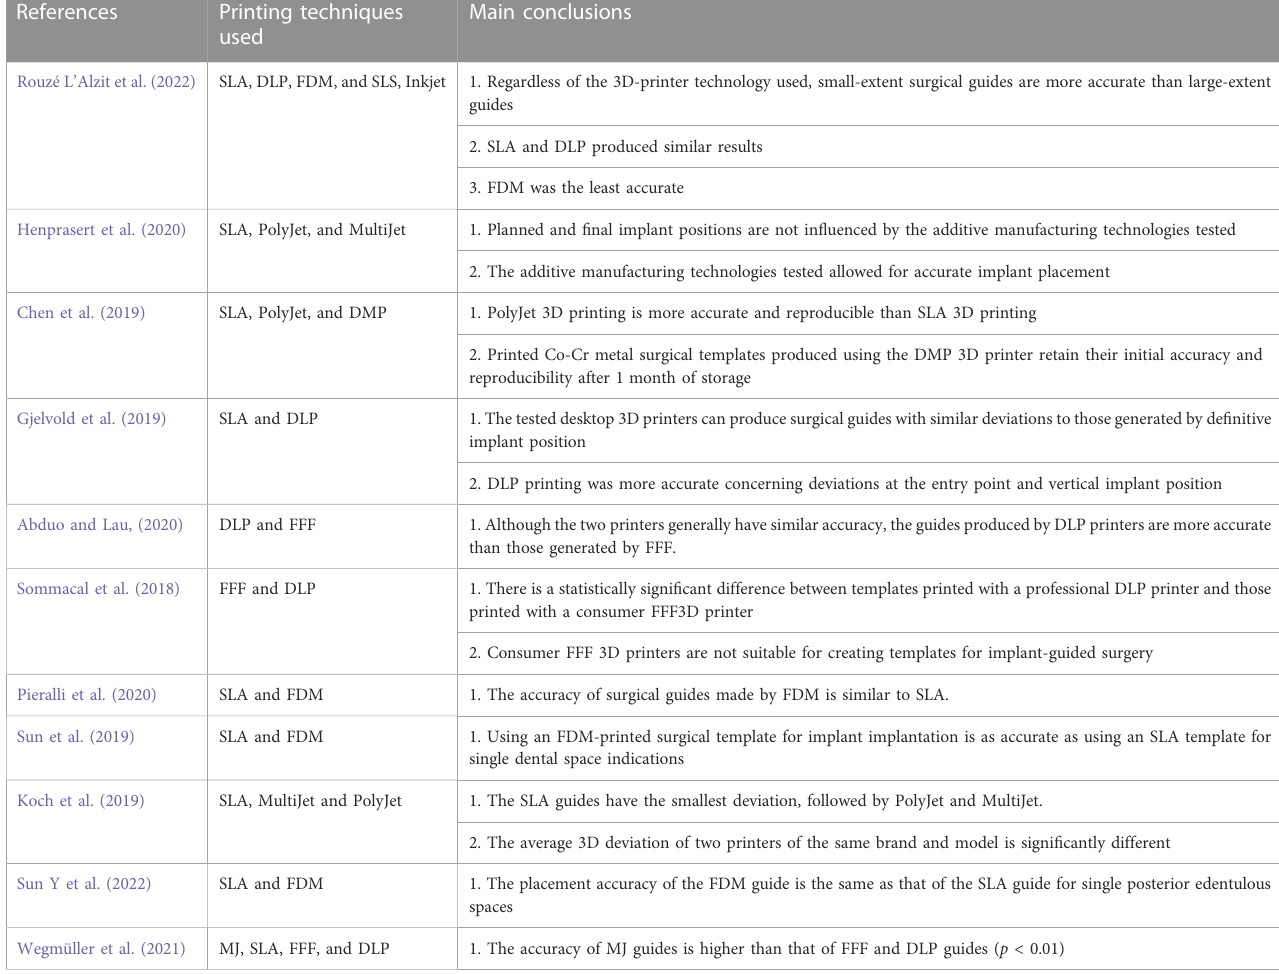
TABLE 1 Accuracy of different 3D printing techniques for fabrication of surgical guides for use in dental